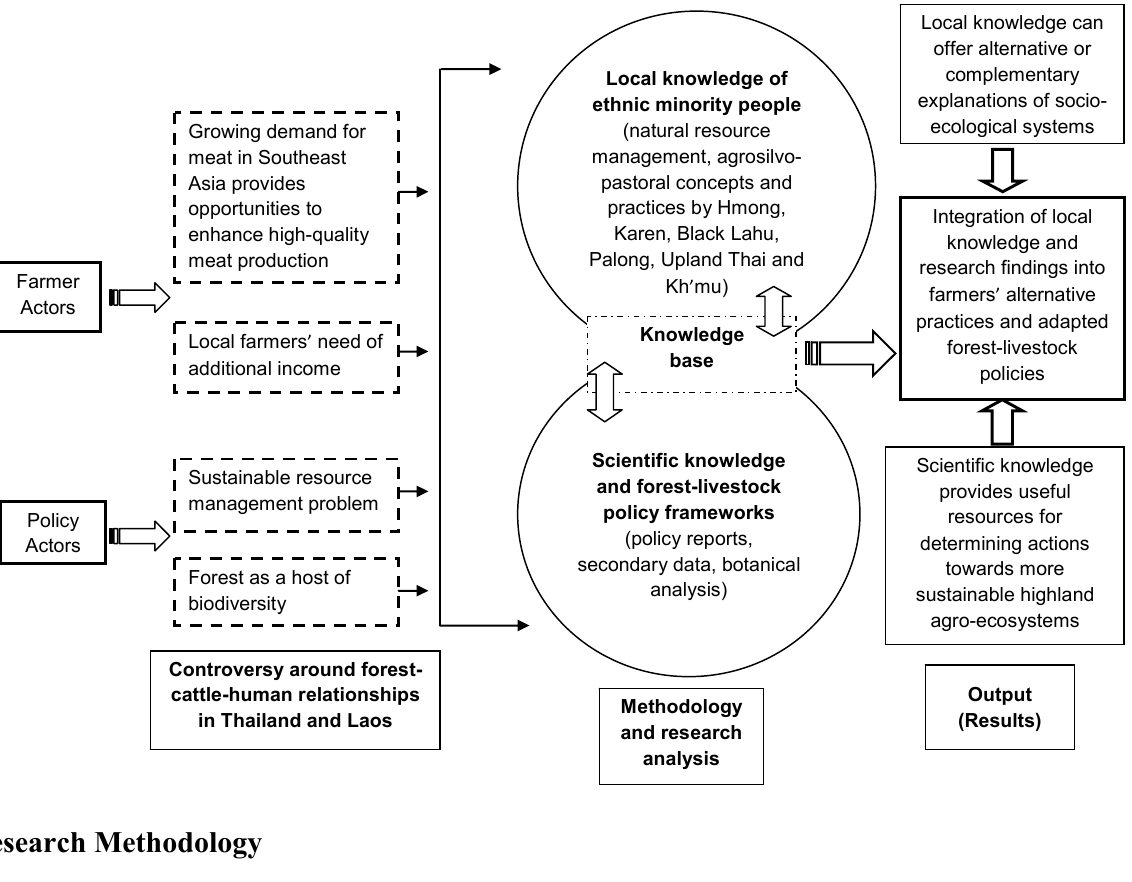
Figure 1. Conceptual framework to assess local knowledge on the traditional agrosilvopastoral systems of upland people in Northern Thailand and Northern